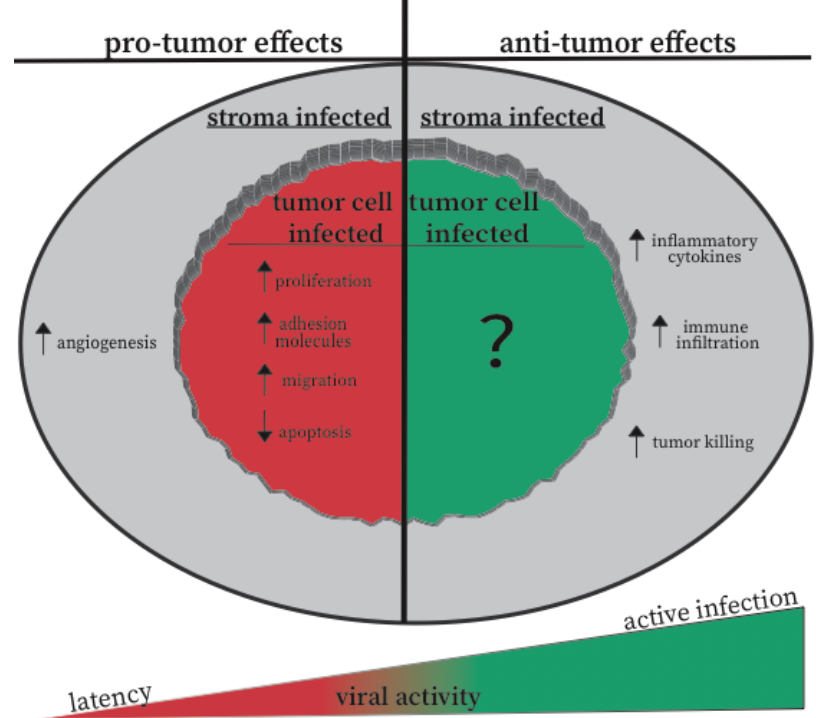
Figure 1. E ff ects of CMV on the tumor cells and microenvironment. The schematic summarizes the experimental evidence for both CMV-mediated tumor promotion and CMV-mediated tumor regression. These e ff ects are classified as to whether the e ff ect can be explained by CMV infection of the tumor cells, or by infection of other cells in the tumor microenvironment. Our hypothesis for how viral activity contributes to these outcomes is also displayed by the wedge-shape on the bottom of the image.